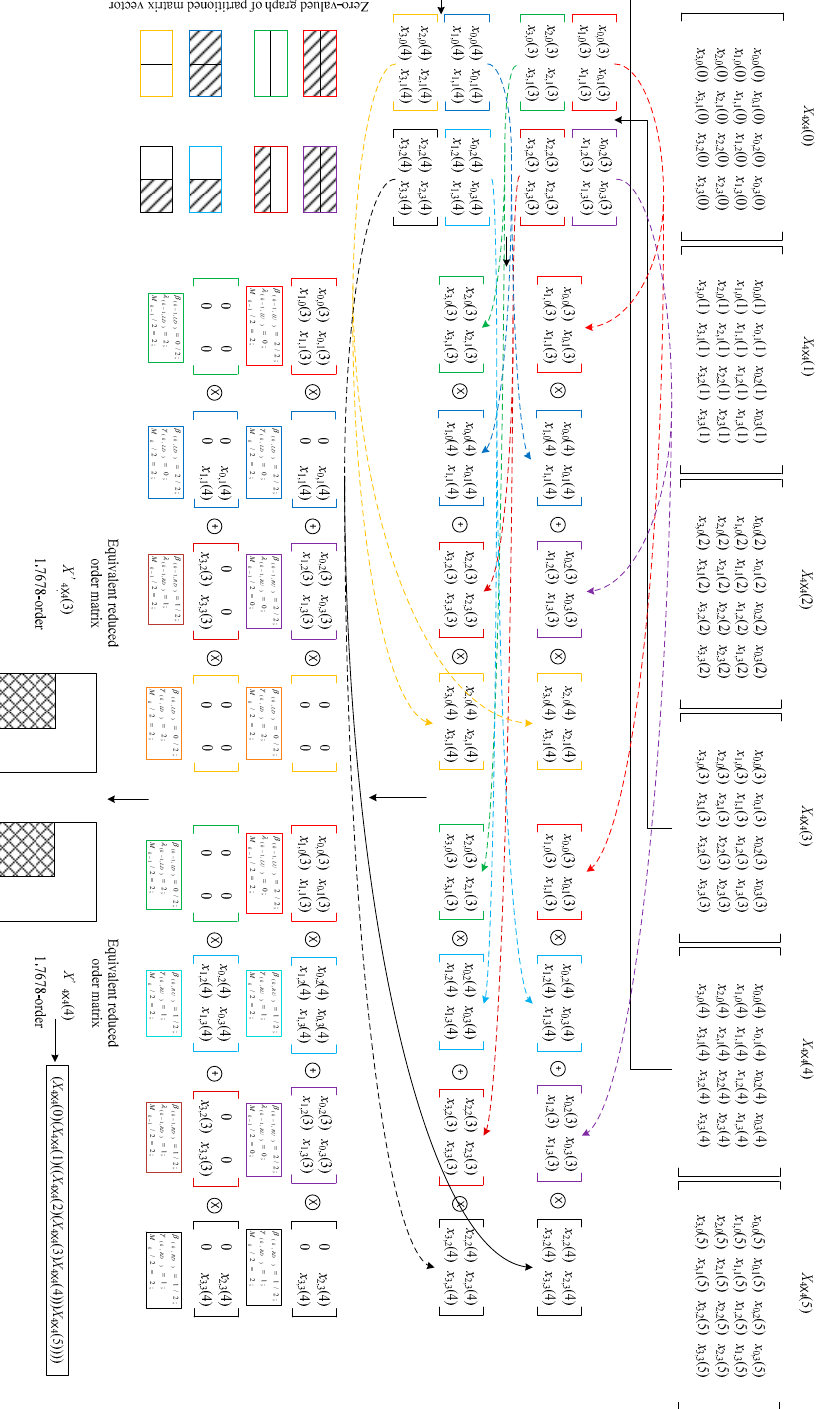
Figure 4. Calculation process of chain multiplication of forward solution of the six-DOF homogene- ous matrix.